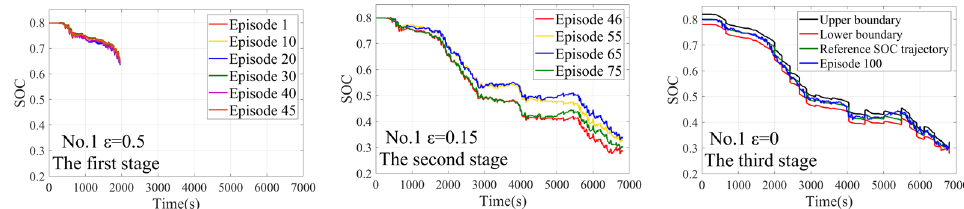
Figure 10. The training process of combined driving cycle 1.